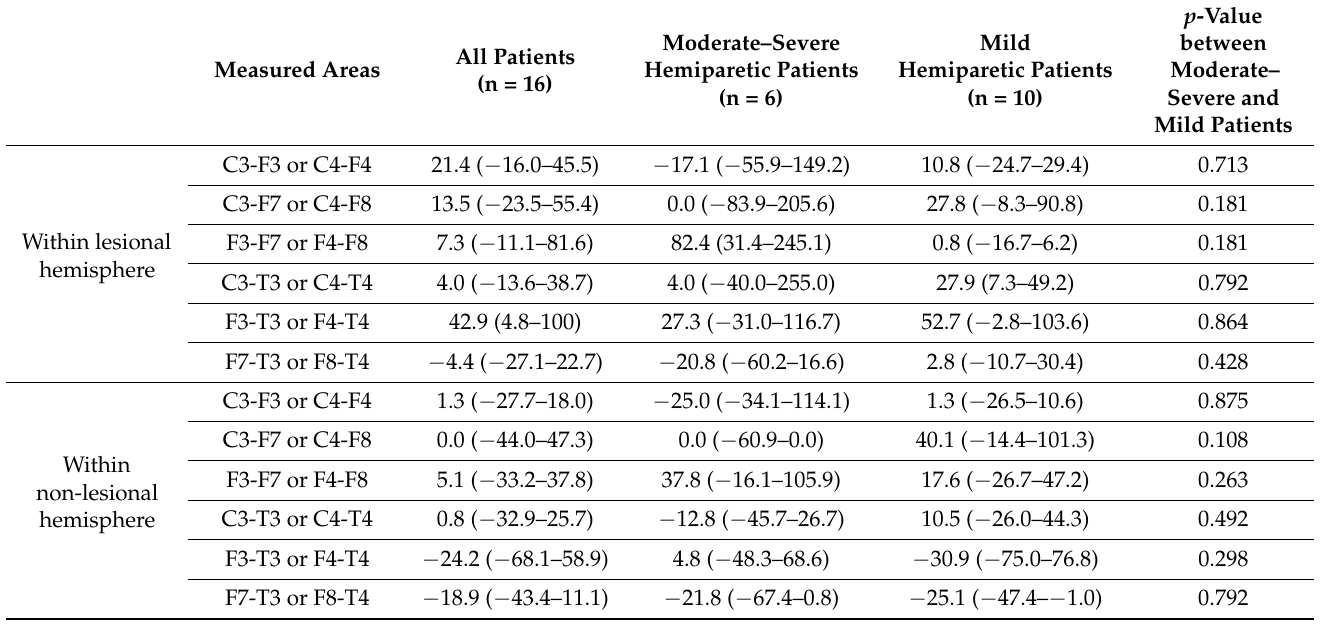
Table 3. Rate of correlation coefficient change with motor task